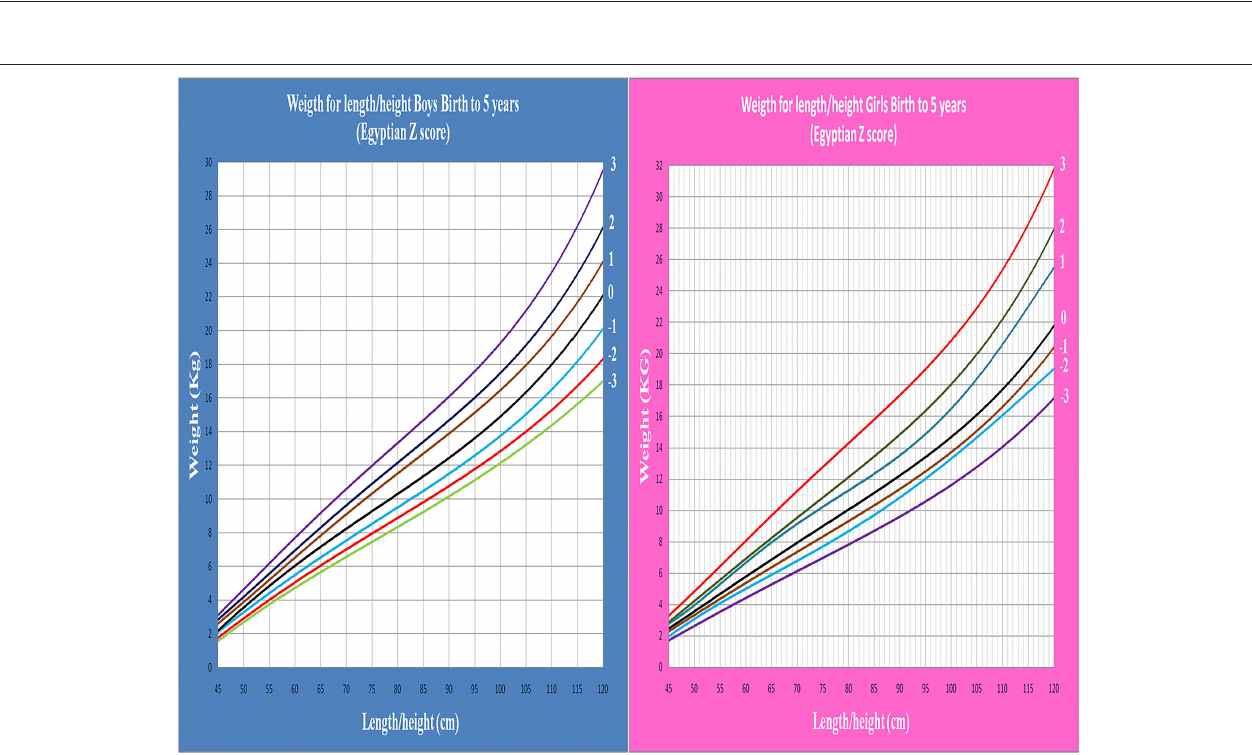
FIGURE 5 | Egyptian Z score weight for length/height from birth to 5 years for boys & girls.